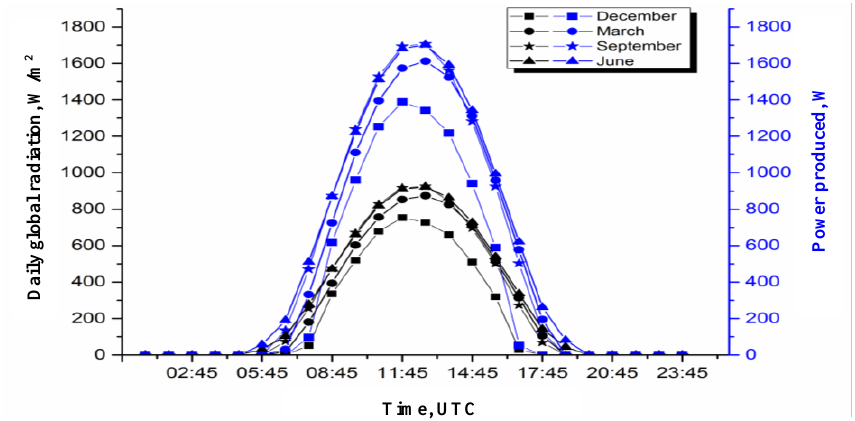
Fig. 4. Daily global radiation and electric power produced by the photovoltaic panels in